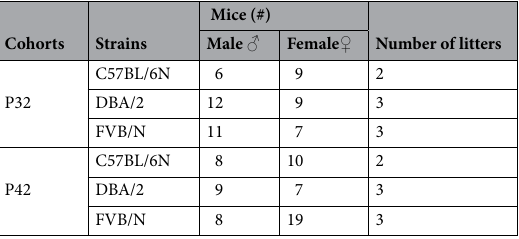
Table 1. Mouse cohorts and numbers of adolescent mice used in the CatWalk XT gait analysis